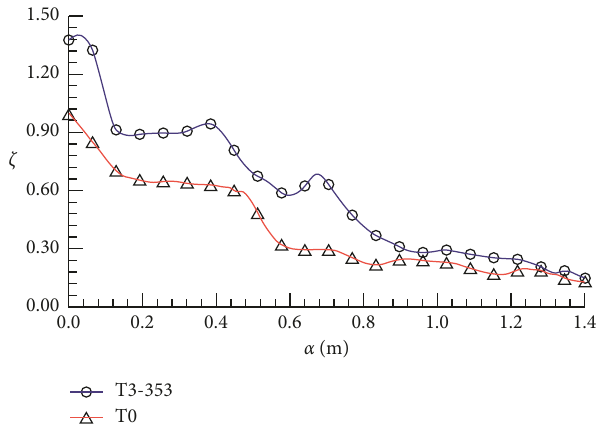
Figure 19: Variation of dissipation rates on L